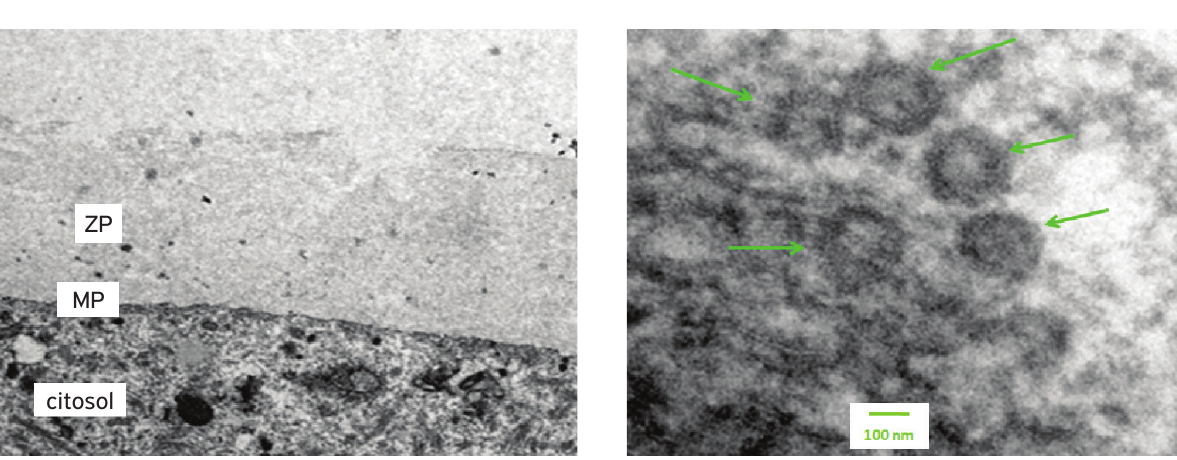
Figura 9. Embrião do grupo controle (Grupo G1). ZP: zona pelúcida; MP: membrana plasmática. Todas estruturas conservadas. Aumento: 7.500x.